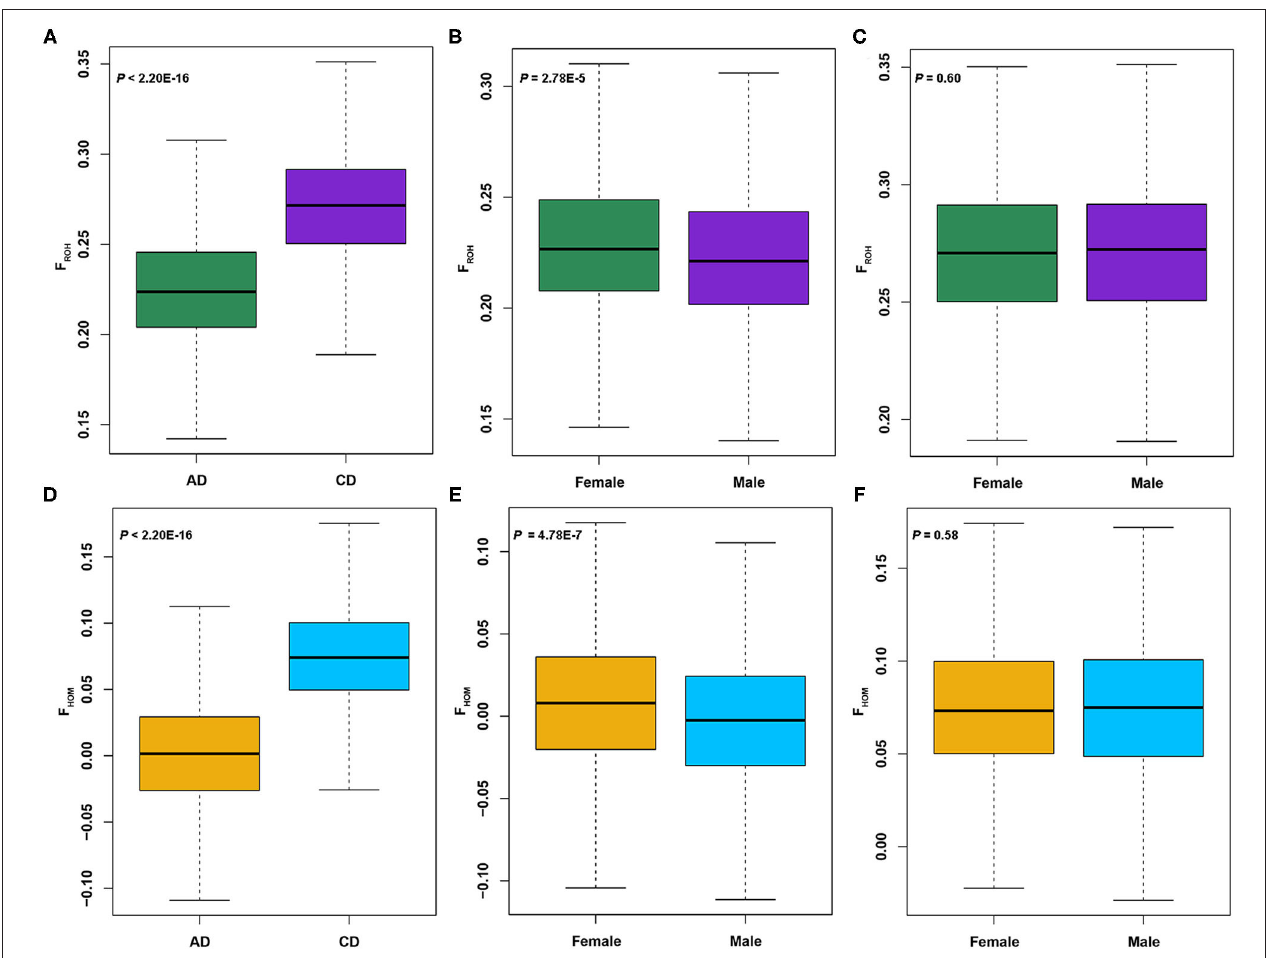
FIGURE 1 | Analysis of the inbreeding coefficients of American Duroc (AD) and Canadian Duroc (CD) pigs based on single-nucleotide polymorphism (SNP) and runs of homozygosity (ROH). (A) F ROH of two Duroc lines. (B,C) F ROH in females and males of AD and CD pigs, respectively. (D) F HOM of two Duroc lines. (E,F) F ROH in females and males of AD and CD pigs,